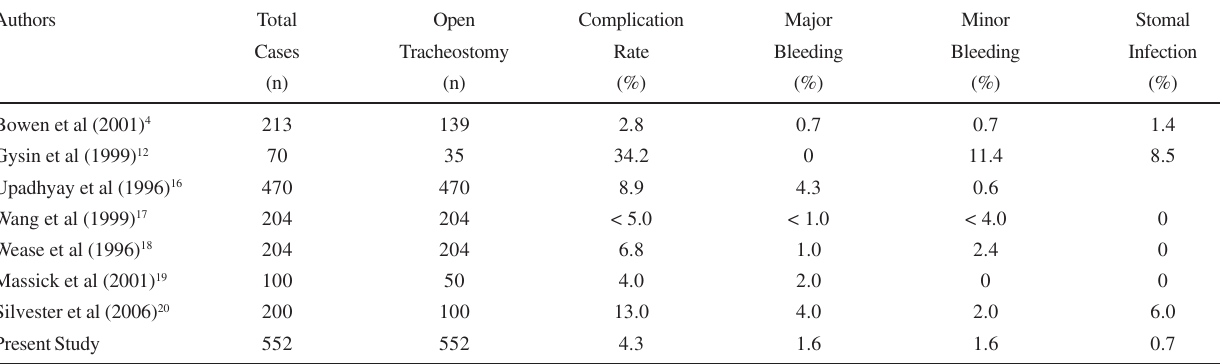
Table 2 - Reported complication rate of open